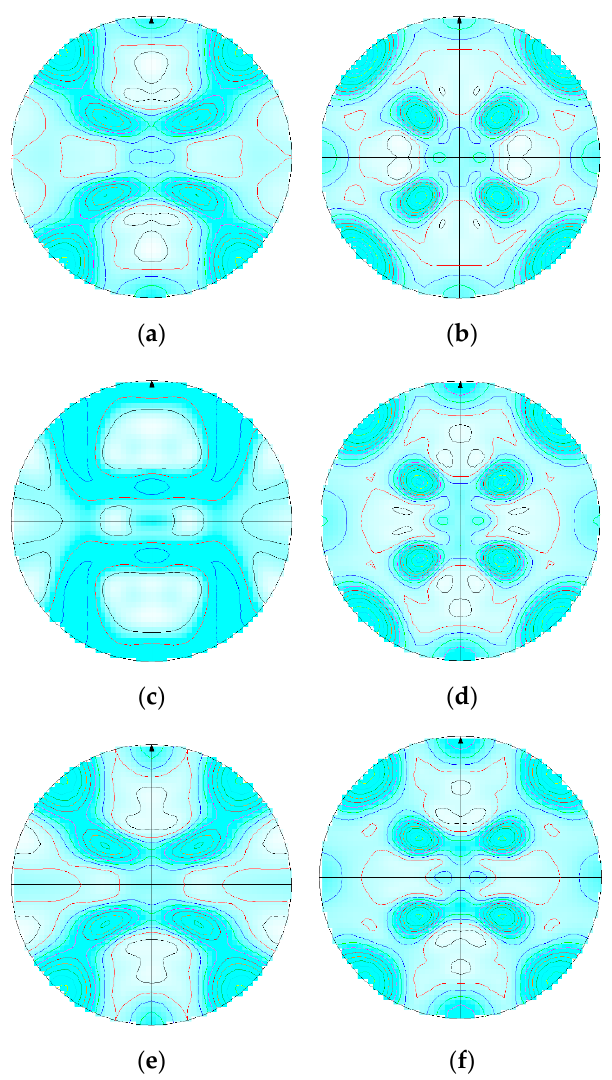
Figure 2. Recalculated {200} pole figures of the samples cold-rolled in 6 steps. ( a ) A1; ( b ) A3K; ( c ) A5; ( d ) A4K; ( e ) A6; ( f ) A9K.